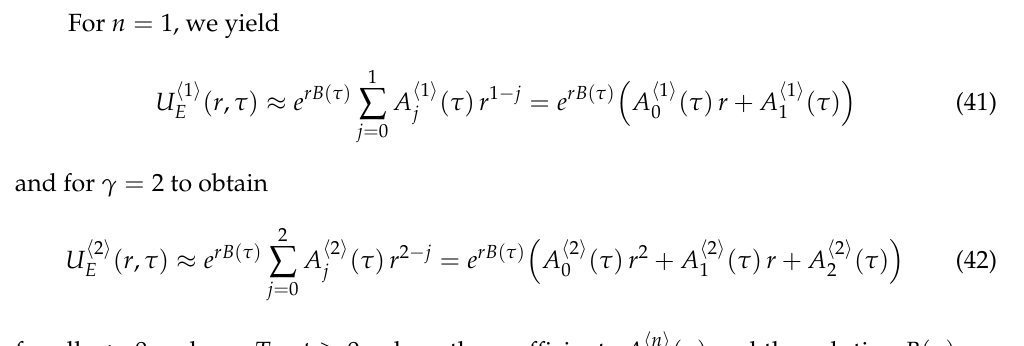
Figure 3. The validation testings of U τ = 0.01,0.1,1,2. ( a ) Conditional expectation U Example 2 (ECIR case with σ 1 = 1) . Use (10) in Theorem 2 under α = 0.01 , β = 0.02 and λ = 0.03 for n = 1, 2